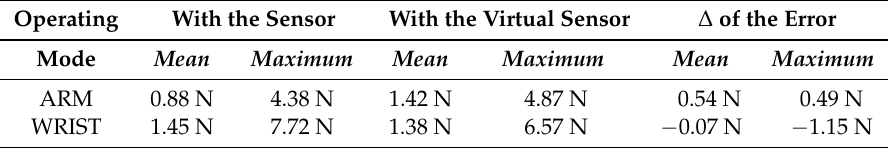
Table 2. Mean and maximum errors of the force controller with zero force reference.